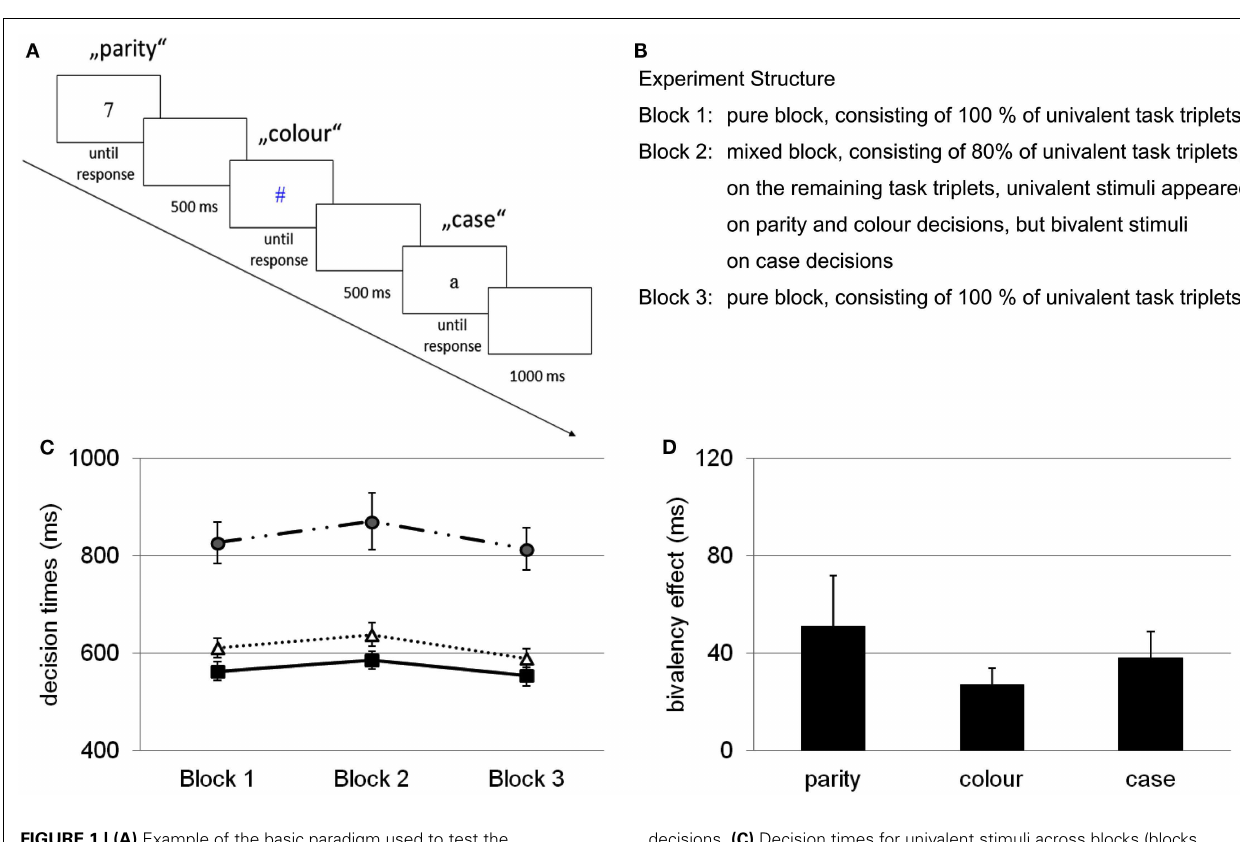
FIGURE 1 | (A) Example of the basic paradigm used to test the influence of occasionally occurring bivalent stimuli. A task-triplet comprised a parity decision, a color decision, and a case decision. On a bivalent task-triplet (not pictured here), the letters were presented in color (either in blue or red). (B) Experiment structure with three blocks of task-switching; bivalent stimuli occur only in block 2 on 20% of case